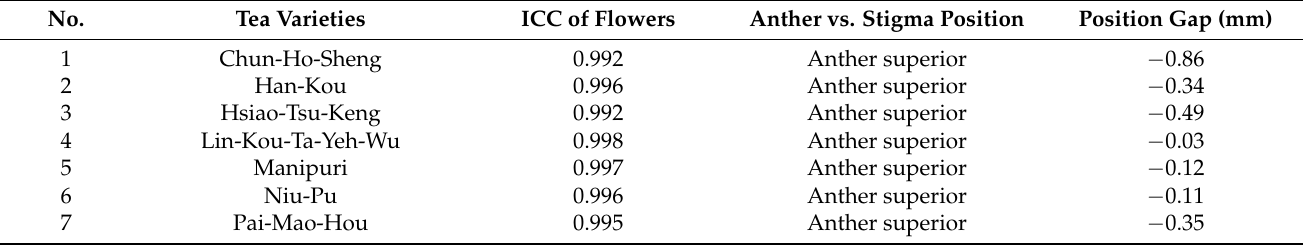
Table 1. Intraclass correlation coefficients (ICCs) of flowers and the anther versus stigma position of the tea